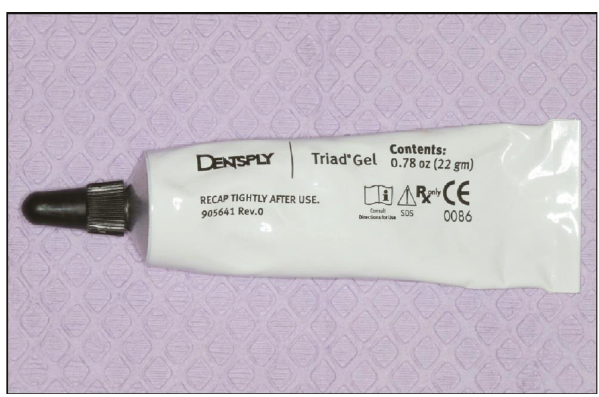
Figure 4: Triad® Gel